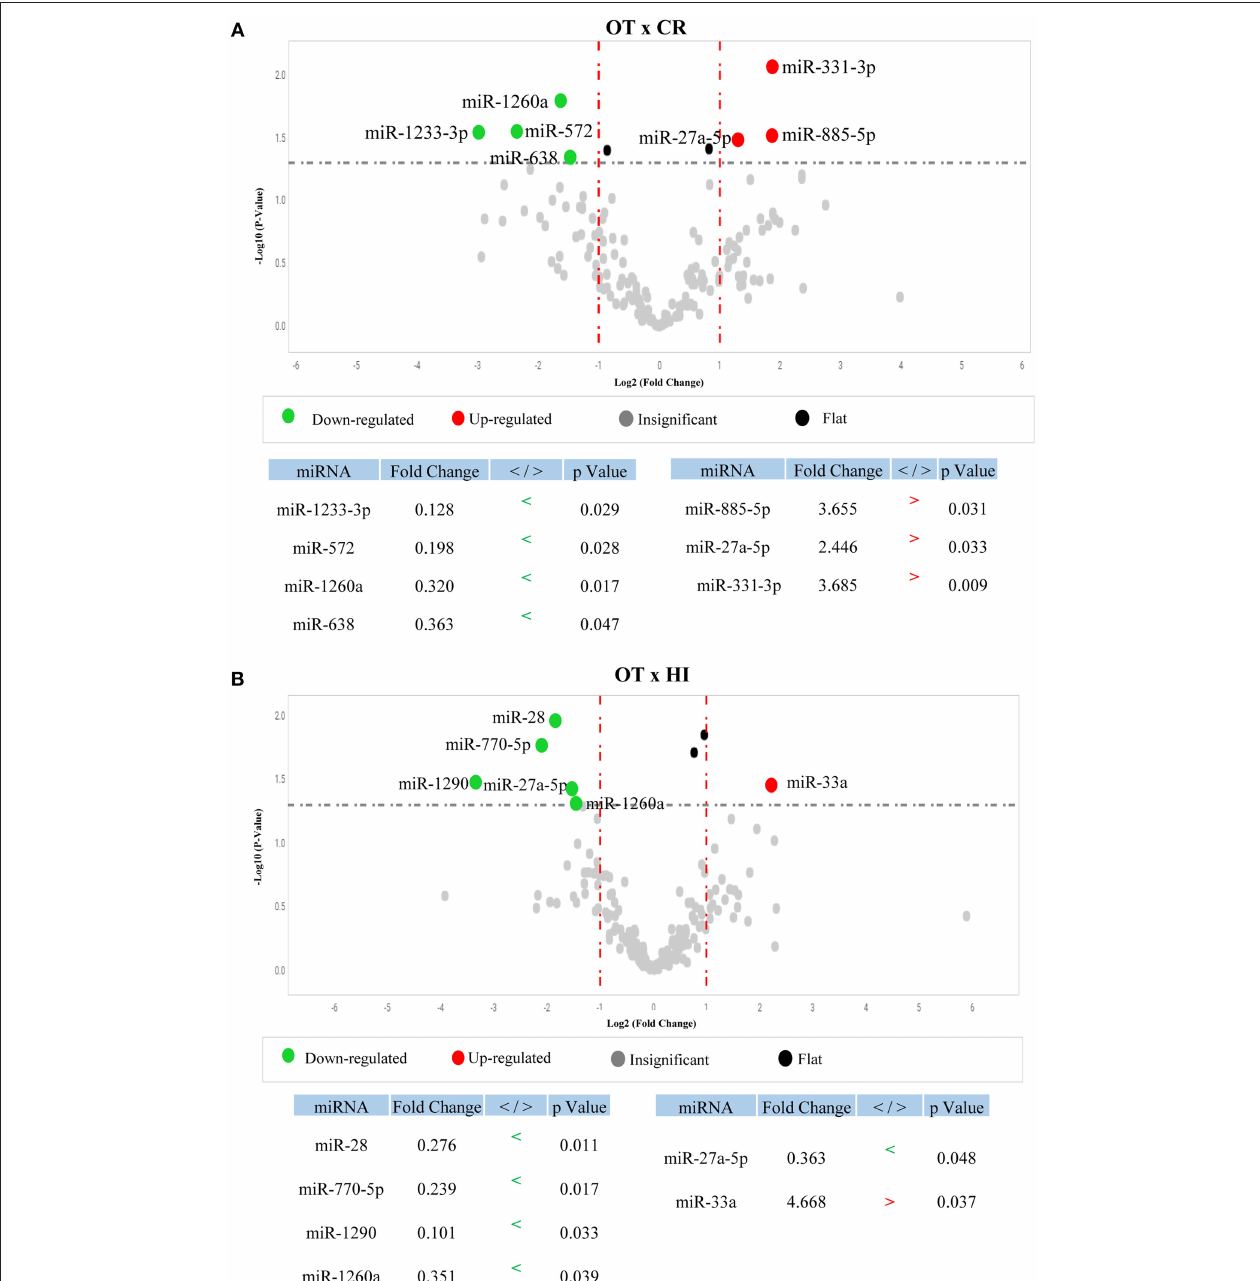
FIGURE 1 | Differential profile of microRNA serum levels in Operational Tolerance. (A) Volcano plot shows microRNAs differentially detected between Operational Tolerance (OT) x Chronic Rejection (CR) ( OT-CR differential profile ). OT n = 8; CR n = 5. Red dots indicate microRNAs with higher levels and green dots indicate lower levels in OT in comparison to CR. The data are shown in fold change (x-axis) and statistical significance (–log10, p -value, y-axis). The dashed gray line indicates that the dots above have a p < 0.05 and the dots below the line a p > 0.05. Statistical calculation by t -test. (B) Volcano plot shows microRNAs differentially detected between Operational Tolerance (OT) x Healthy Individuals (HI). OT n = 8; HI n = 5. Red dots indicate microRNAs with higher levels and green dots indicate lower levels in OT in comparison to HI. The data are shown in fold change (x-axis) and statistical significance (–log10, p -value, y-axis). The dashed gray line indicates that the dots above have a p < 0.05 and the dots below the line a p > 0.05. Statistical calculation by t -test.